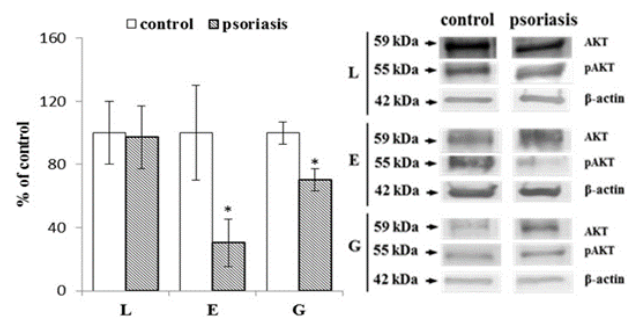
Figure 5. Phosphorylated AKT (pAKT) / AKT expression ratio in lymphocytes (L), erythrocytes (E), and granulocytes (G) from psoriatic patients ( n = 6), in comparison to healthy subjects (control), ( n = 6). Values are expressed as a percentage of control. ∗ —statistical significance at p < 0.05 vs. control.